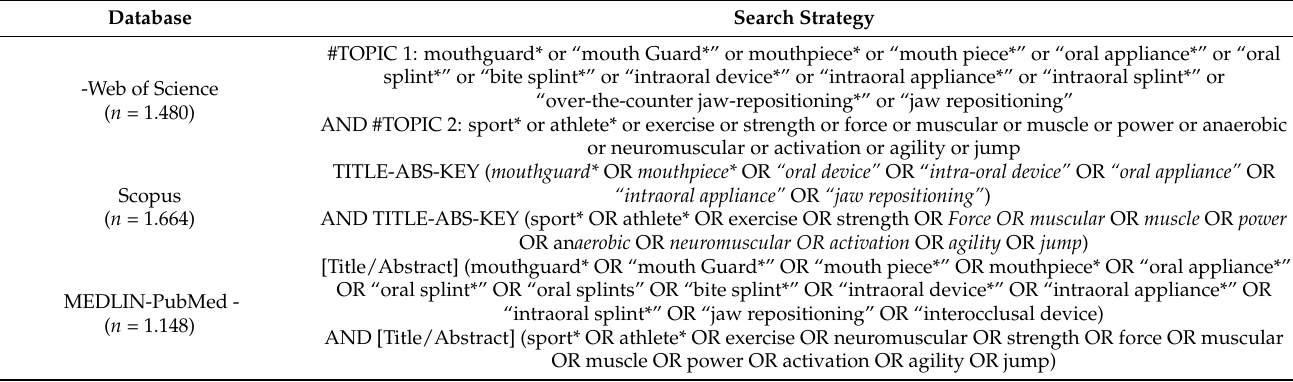
Table 2. Search strategy and databases